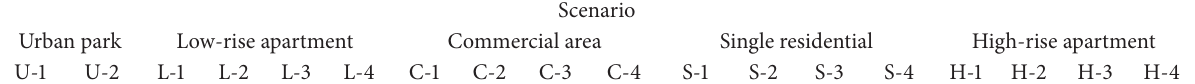
Table 6: Differences in surface temperature of existing spaces and space